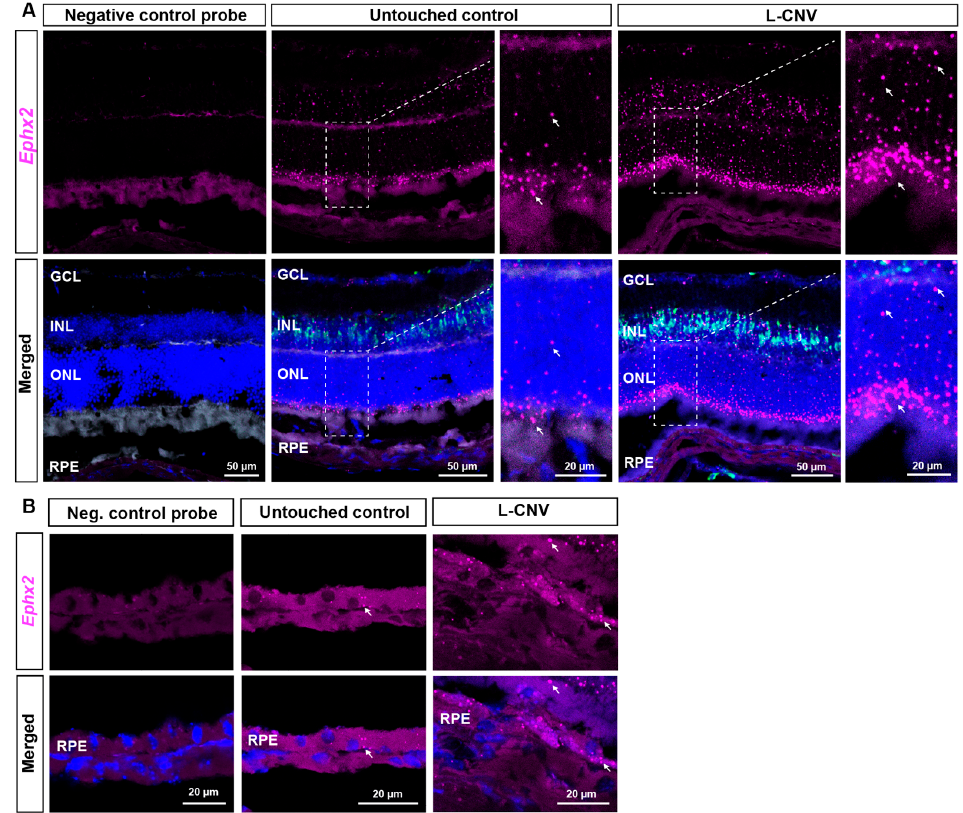
Figure 4. sEH mRNA expression is increased in the photoreceptors and retinal pigment epithelium (RPE) of mouse L-CNV eyes. Representative images of retinal sections near L-CNV lesions from eyes of murine L-CNV 3 days post-laser (labeled as L-CNV in horizontal box) and untouched control eyes. Ephx2 mRNA encoding murine sEH is in magenta, Apoe mRNA (glial cell marker) is in green, and DAPI is in blue. ( A ) Ephx2 mRNA is detected throughout all cellular layers of the retina, but its signal is most prominently increased in the INL and ONL of the photoreceptor cells in L-CNV (white arrows). Ephx2 is detected in the INL where Apoe was also localized in glial cells. Ephx2 mRNA is present at high levels in the ONL, as shown in the inset images of the same sections taken at higher magnification. ( B ) Ephx2 mRNA is expressed at low levels in the RPE of the untouched control, whereas its expression is enhanced in the RPE of the L-CNV eyes (white arrows). Bright fluorescent puncta represent positive RNA signal. Scale bars as indicated. Representative images from n = 3 control and n = 3 L-CNV mice.